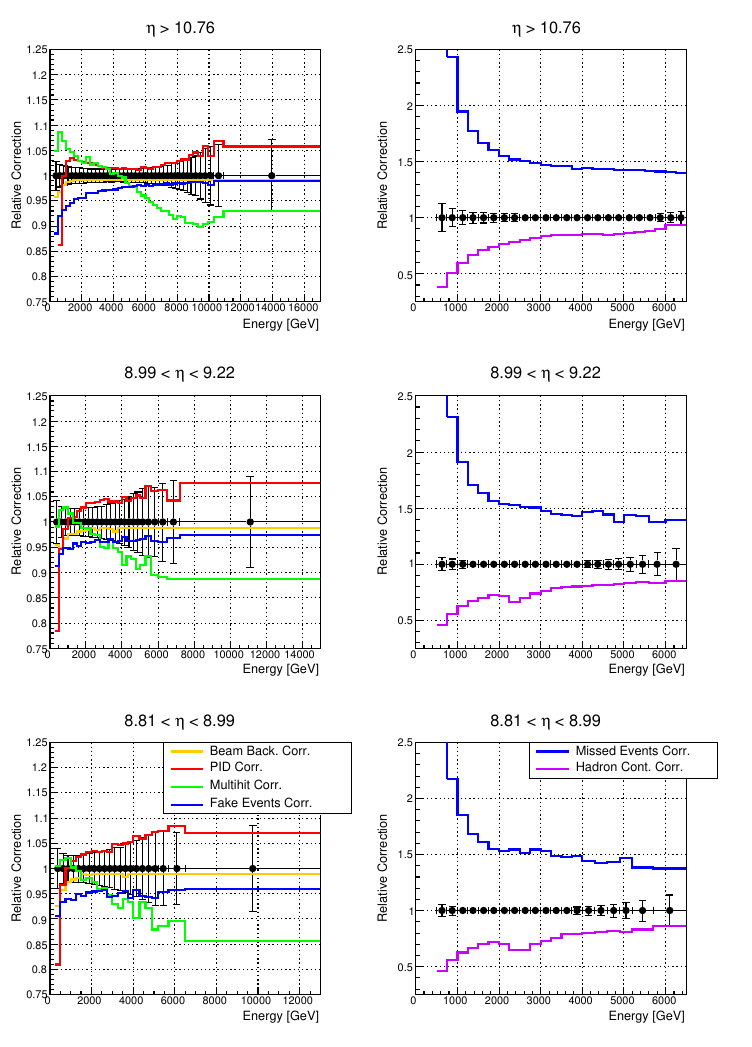
Figure 2 . Relative correction factors before (left) and after (right) unfolding. In the two cases, black markers show the statistical error present on the folded and the unfolded distributions, re- spectively. The di(cid:11)erent colors represent the relative change of the histograms after each